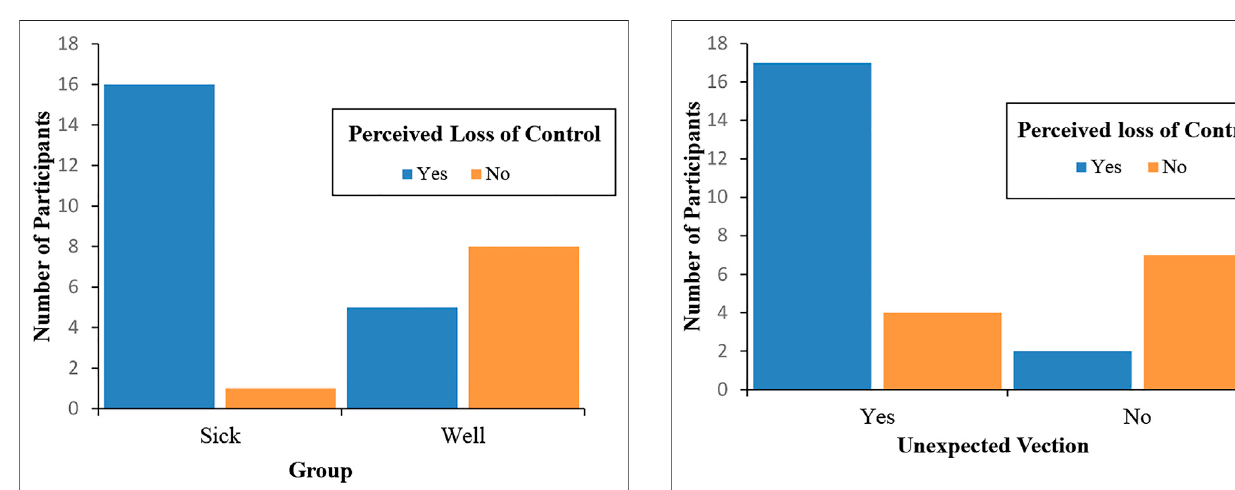
FIGURE 4 | Shows the associations between vection type and perceived control. Most participants who experienced unexpected vection also experienced a perceived loss of